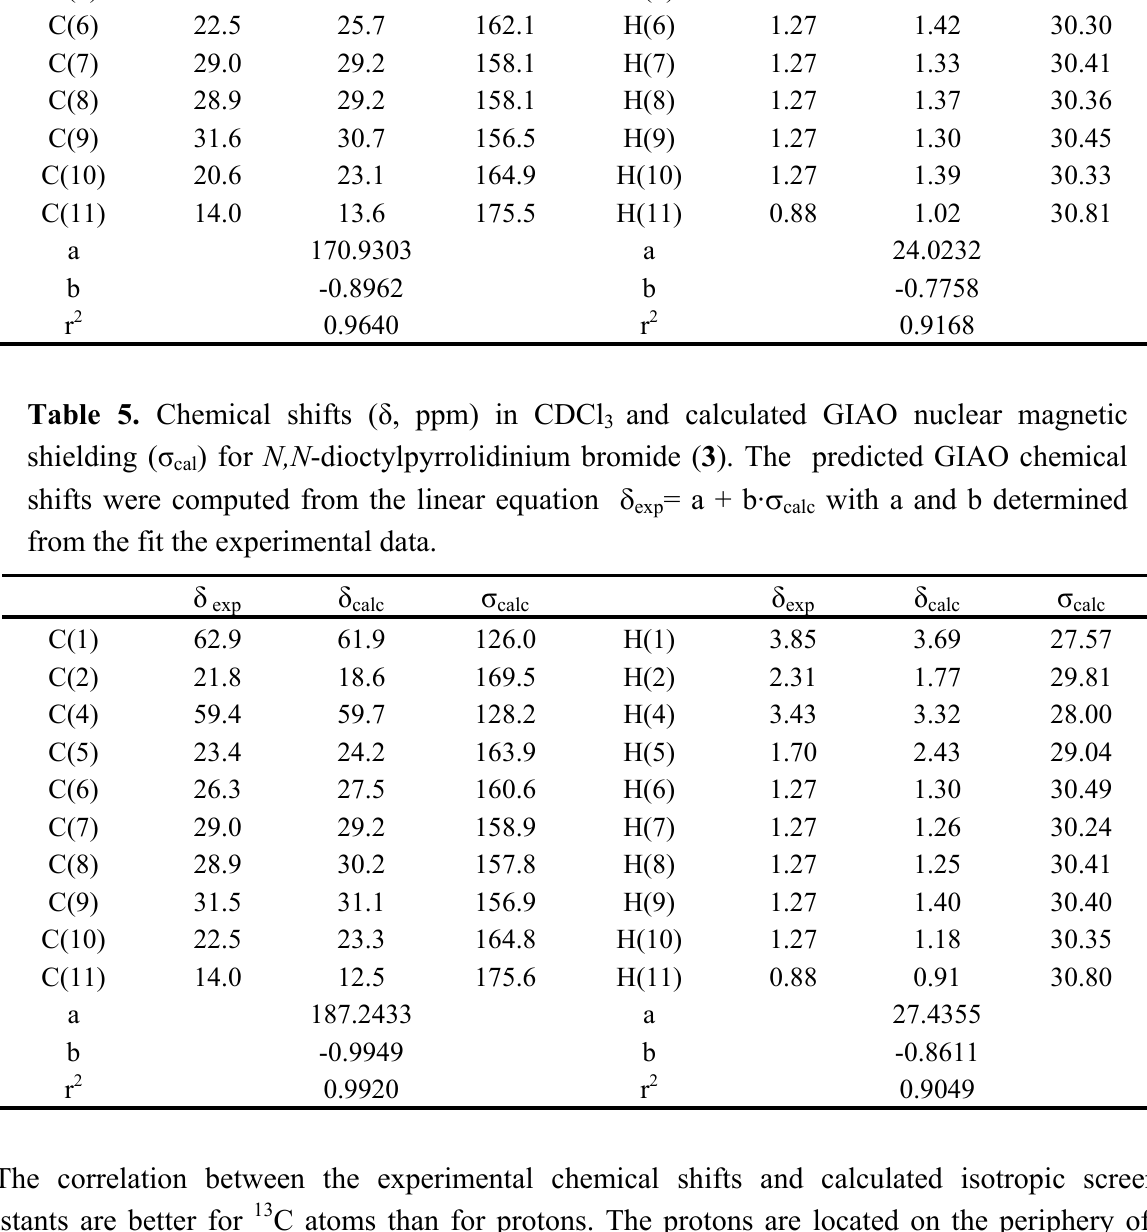
Table 4. Chemical shifts ( δ , ppm) in CDCl shielding ( σ ) for N,N -dioctylpiperidinium bromide ( 2 ). The predicted GIAO chemical cal shifts were computed from the linear equation δ from the fit the experimental data.